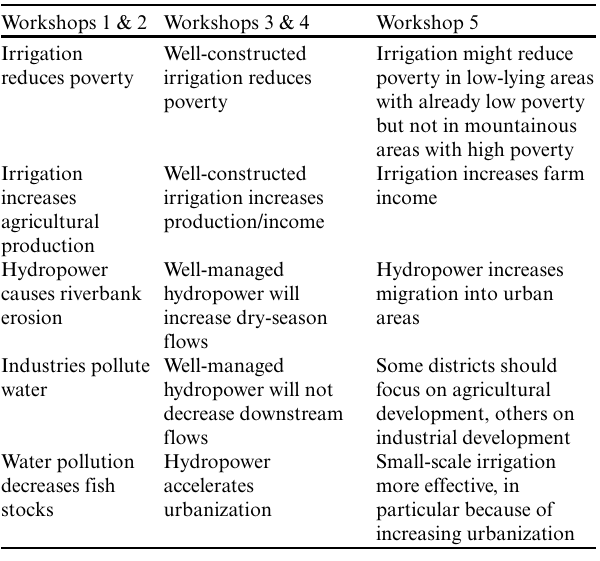
Table 2 . Beliefs recorded during the workshop process in the Nam Ngum, Lao